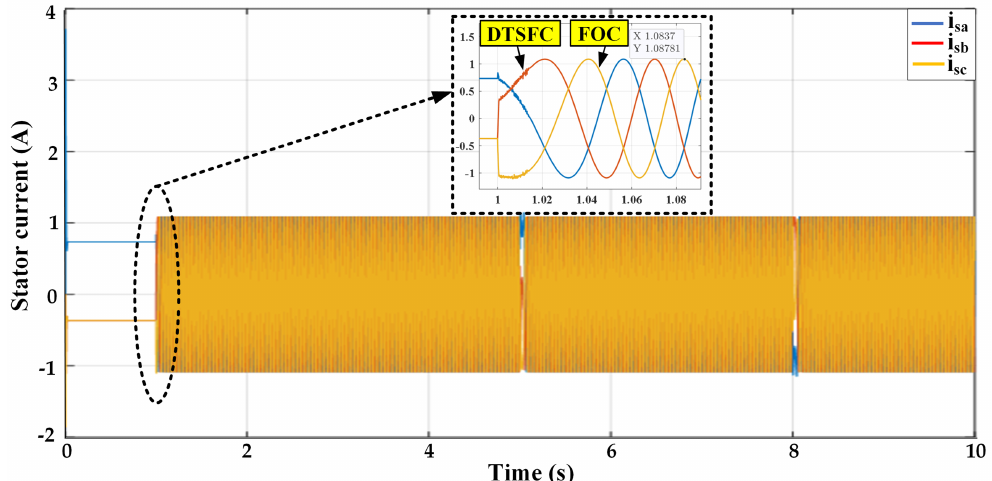
Figure 23. Three-phase currents of the proposed combined FOC-DTC